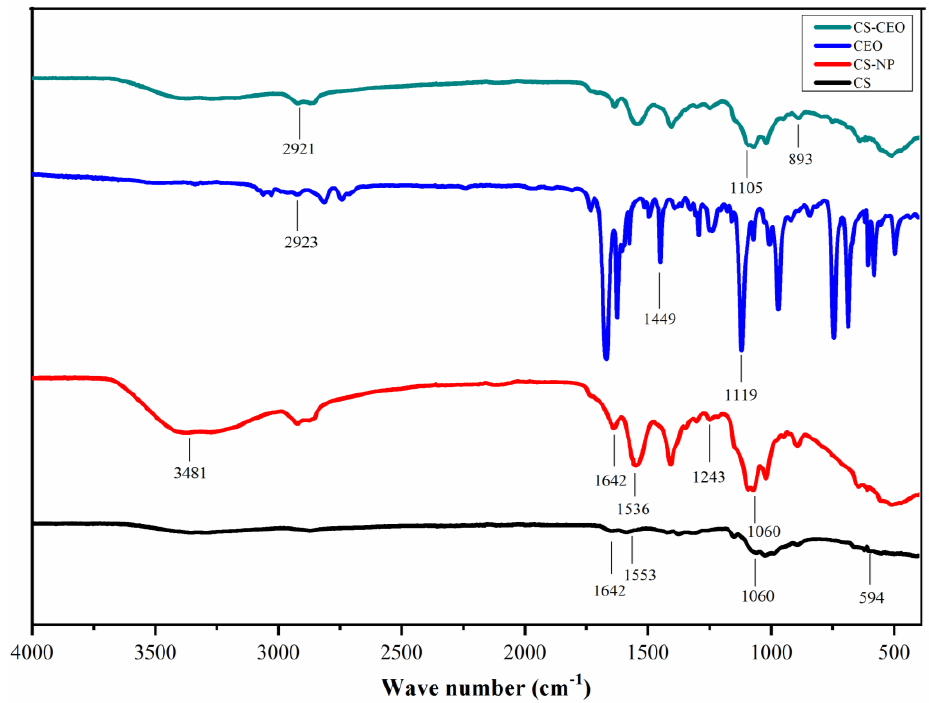
Figure 4. FT – IR spectra of CS, CS-NPs, CEO, and CS-CEO loaded at a CEO to CS weight ratio of 0.39:1.